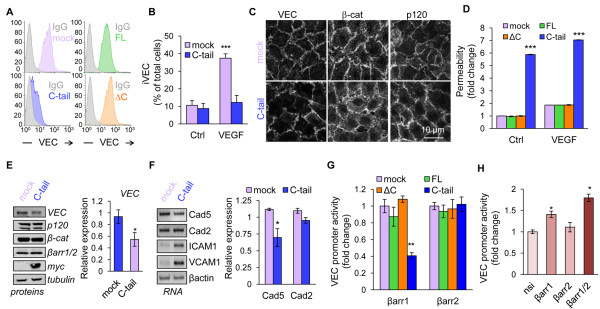
β-arrestin1 C-terminus tail induces loss of barrier integrity and VE-cadherin down-regulation. (A) VE-cadherin surface expression was tested by flow cytometry in HUVEC that stably expressed mock (pink) or CFP-myc-tagged β-arrestin1 full-length (1–418, green), ΔC (1–374, orange) and C-tail (375–418, blue). Isotype control (Ig) is shown in grey. (B) Mock and C-tail HUVEC were subjected to VE-cadherin internalization assay (iVEC) and analyzed by confocal microscopy. Graph represents the mean + s.e.m. of the percentage of cells with iVEC staining; n >300; T-test: *** p < 0.001. (C) Three day-old mock and C-tail HUVEC were stained for VE-cadherin (VEC), β-catenin (β-cat) and p120-catenin (p120) and analyzed by confocal microscopy. Scale bar: 10 μm. (D) Relative permeability was measured in mock, FL, ΔC and C-tail HUVEC by the fluorescence of 40 kDa FITC-dextran passage. Graph shows the mean ± s.e.m. of 3 independent experiments. Two-way ANOVA test: *** p < 0.001. (E-F) Protein and RNA expression of indicated targets were tested using western-blot (E) and RT-PCR (F) in mock and C-tail HUVEC. Cad5: cadherin-5, VE-cadherin; Cad2: cadherin-2, N-cadherin. Densitometry analysis was done with Image J software. T-test: * p < 0.05. (G-H) HUVEC were transfected with luciferase reporter for VE-cadherin promoter activity and Renilla. (G) They also received a control CFP-myc plasmid (mock) and the CFP-myc-tagged FL, ΔC and C-tail β-arrestin1. Alternatively, they received pGFP (mock) and GFP-tagged β-arrestin2 comprising amino acids 1–410 (FL), 1–359 (ΔC) and 317–410 (C-tail). (H) Two days prior plasmid transfection, cells were treated with non-silencing duplexes (nsi) and siRNA targeting βarr1, βarr2, or both (βarr1/2). Graphs show the mean ± s.e.m. of 3 independent experiments. Two-way and one-way ANOVA test: ** p < 0.01; * p < 0.05. All panels are representative of at least 3 independent experiments.